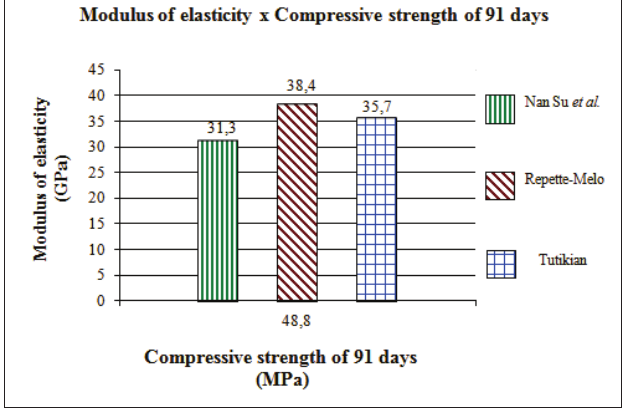
Figure 9 – modulus of elasticity comparison for the same range of compressive strength of 91 days for all methods